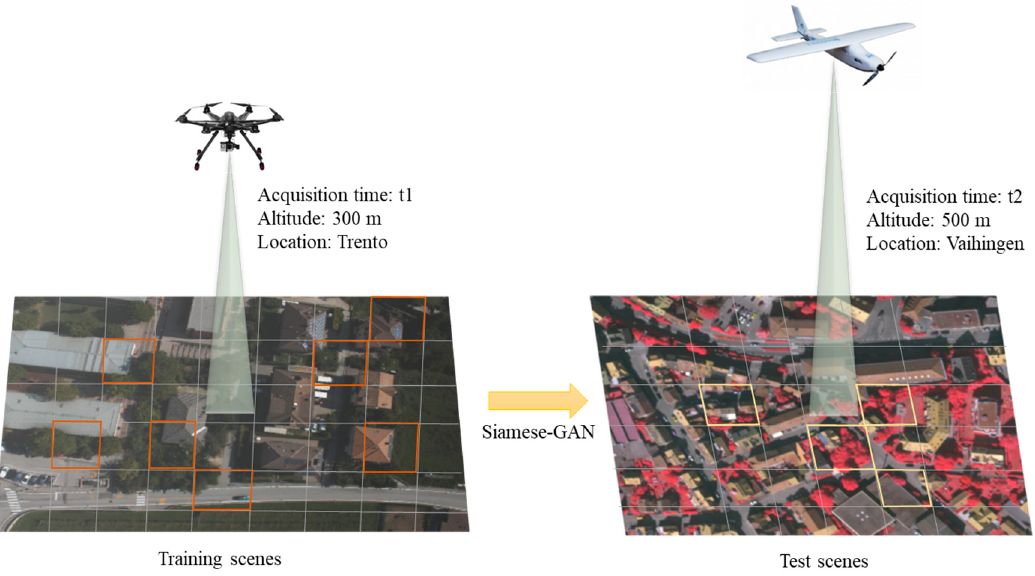
Figure 2. Cross-domain classification: use training samples from a previous domain to classify data coming from a new domain.